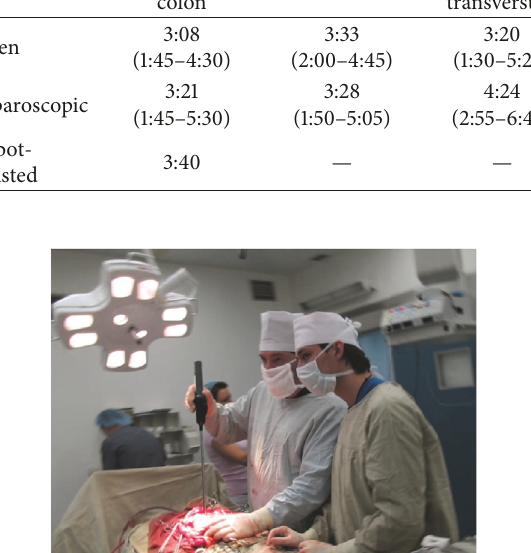
Figure 3: Instrumental mechanoreceptoric palpation in an open